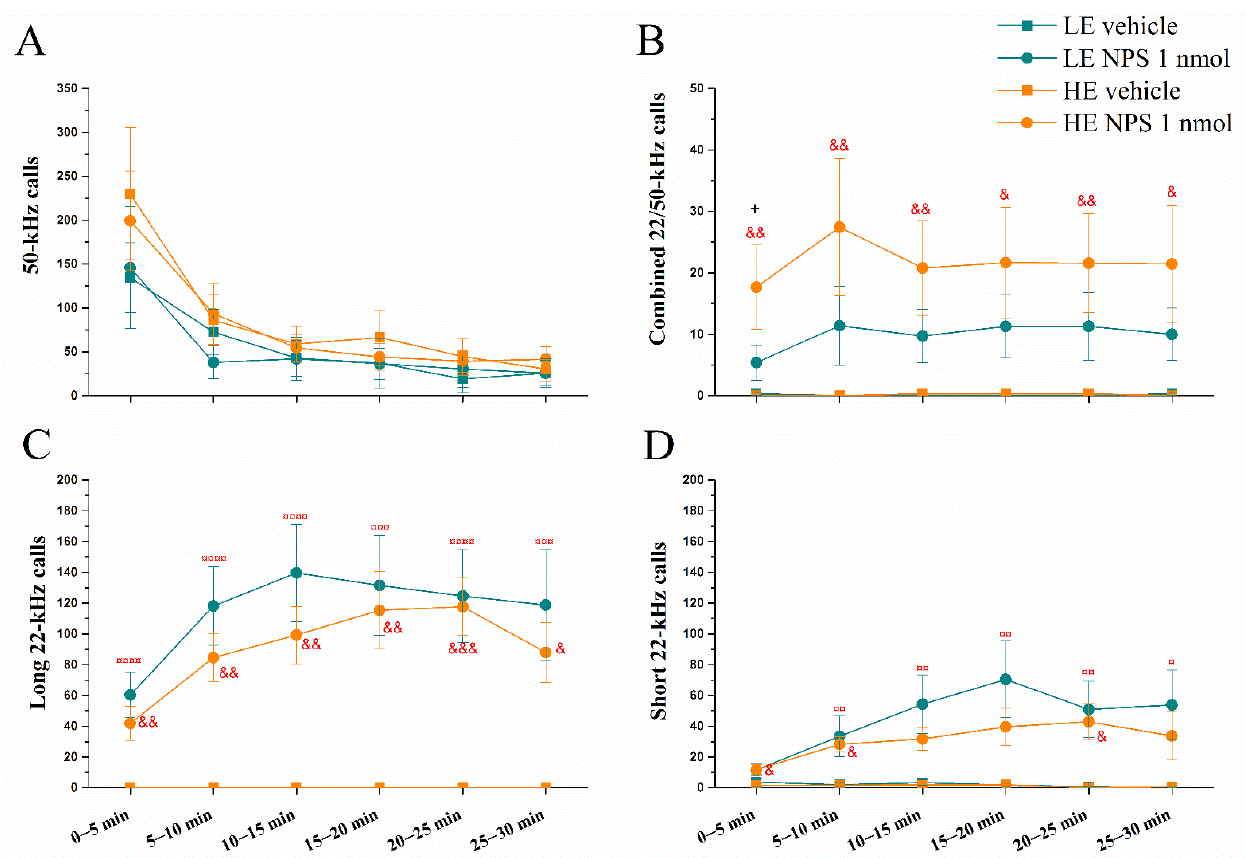
Figure 2. Number of ultrasonic vocalizations emitted in the rat’s home-cage after administration of vehicle/NPS (1 nmol, i.c.v.): 50 kHz ( A ), combined 22/50 kHz ( B ), long 22 kHz ( C ) and short 22 kHz ( D ) calls (data shown as mean ± SEM). &, &&, &&&: p < 0.05, 0.01, 0.001 vs. HE vehicle, respectively; ¤, ¤¤, ¤¤¤, ¤¤¤¤: p < 0.05, 0.01, 0.001, 0.0001 vs. LE vehicle, respectively; +: p < 0.05 vs. LE NPS. Red colour denotes difference from respective vehicle group. HE: high exploring rats; LE: low exploring rats; NPS: neuropeptide S. HE vehicle ( n = 7); HE NPS ( n = 9); LE vehicle ( n = 10); LE NPS ( n = 10).